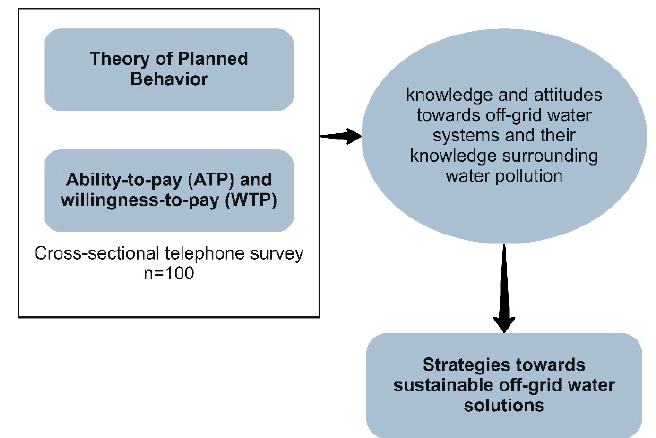
Figure 3. Research Figure 3. Research framework. Figure 3. Research framework.